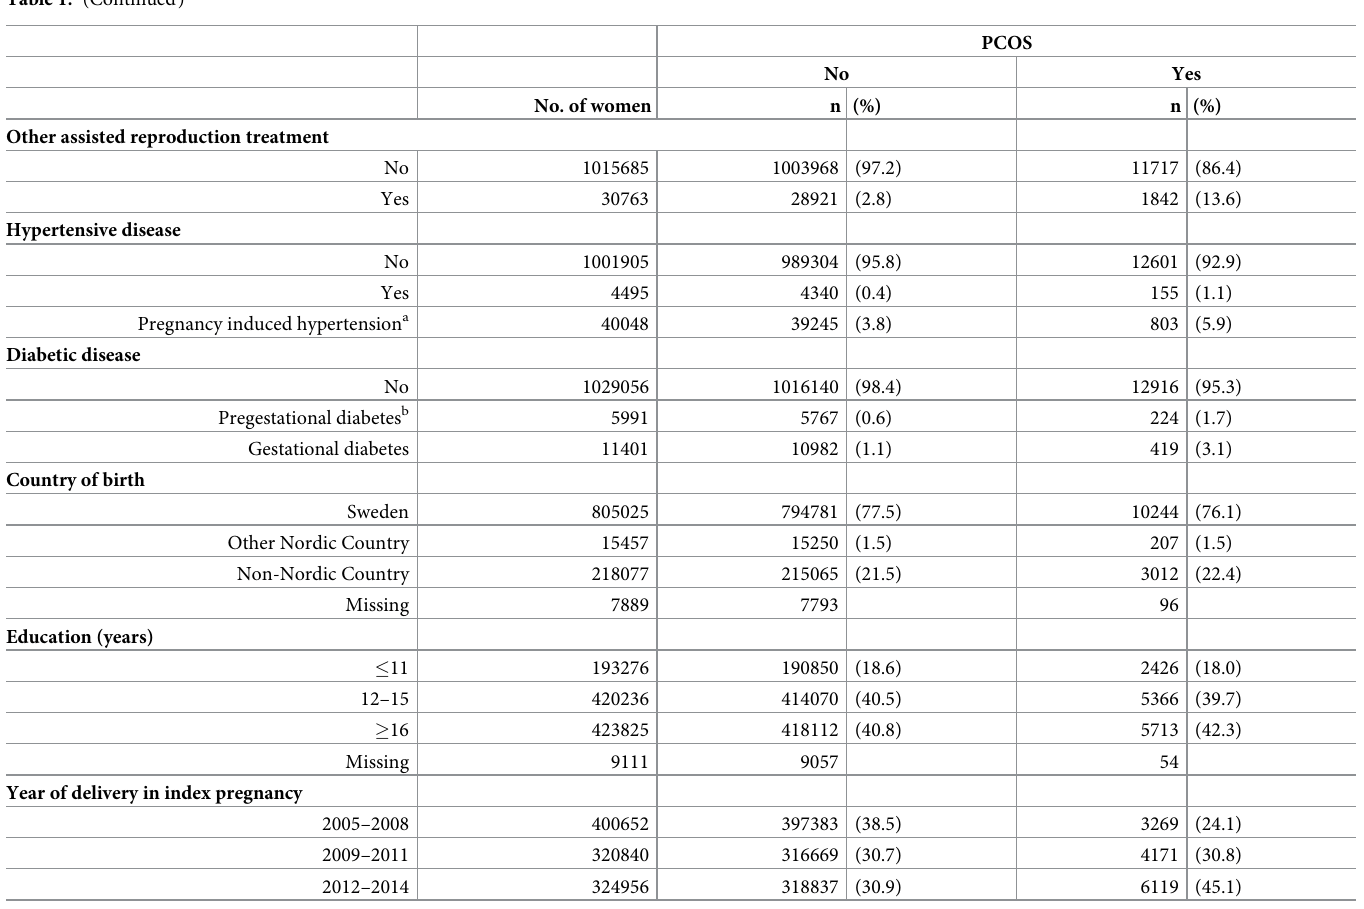
tolerance test. Diagnostic criteria for gestational diabetes varied between counties in Sweden, but ranged between glucose level 9.0–11.1 mmol/L, using either capillary or venous samples, obtained two hours after intake of 75 gram glucose solution, or a fasting glucose level between 6.1–7.0 mmol/L. During the study years, metformin was rarely used during pregnancy (for neither PCOS nor gestational diabetes). See S1 Table for ICD codes for hypertensive and dia- betic